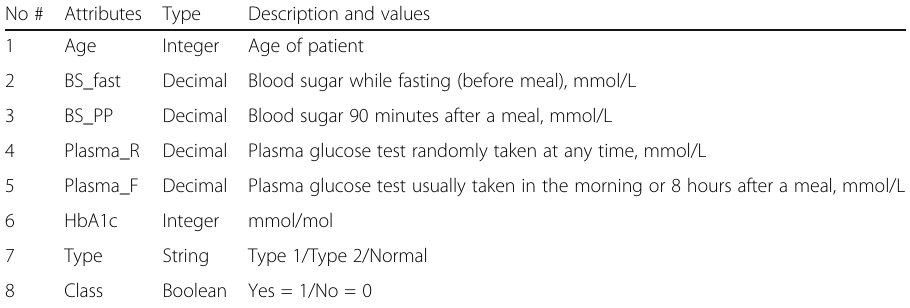
Table 2 Features of diabetes type dataset